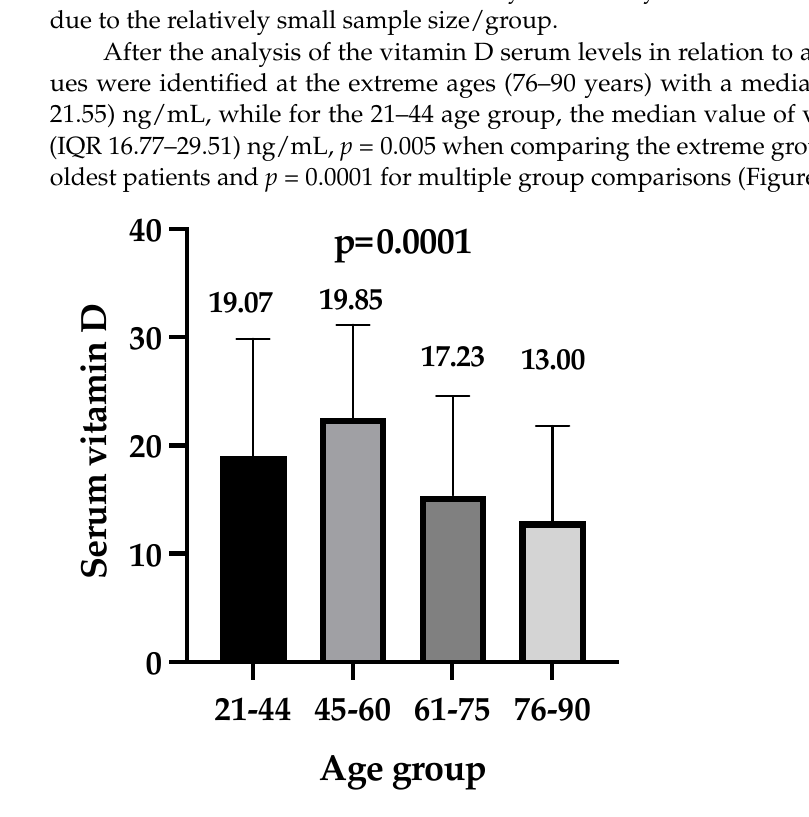
Figure 1. Serum levels of vitamin D were stratified by age groups. Results were analyzed with the Kruskal–Wallis test and Dunn’s for multiple comparisons groups. Box plot (median and interquartile range): the horizontal lines depict the 75% percentile, and the top of the box plot is the median.